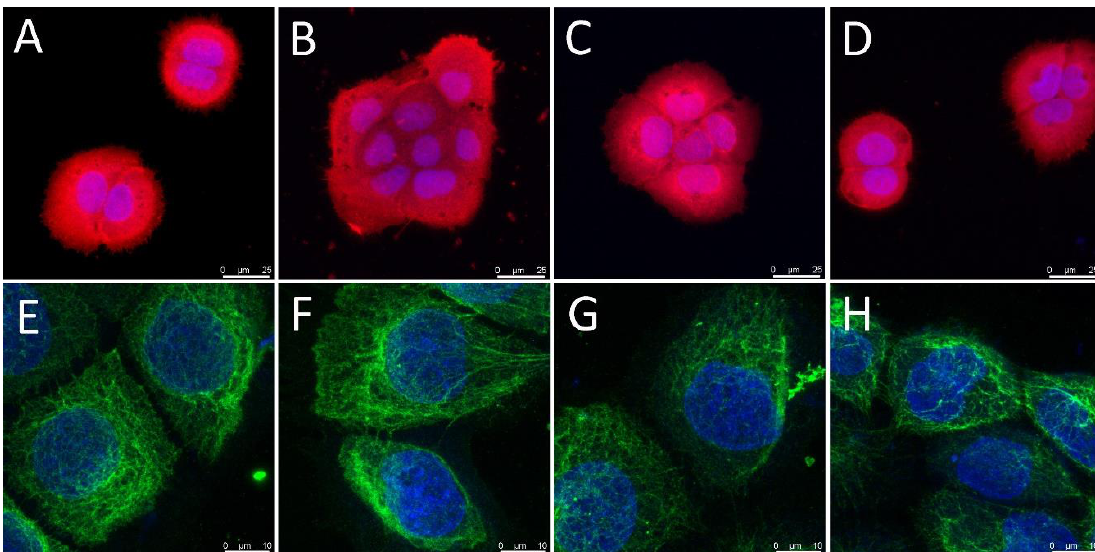
Figure 5. Texas Red C 2 -maleimide staining of the HaCaT cells on day 1 following seeding ( A – D ), and the immunofluores- cence staining of the basal cytokeratins in these cells on day 3 following seeding ( E – H ). The cells were seeded on glass in DMEM containing 2% of FS without the presence of PL ( A , E ), with the presence of 2.5% of PL ( B , F ), with the presence of PVA nanomats ( C , G ) and with the presence of PVA–PL nanomats ( D , H ). The cell nuclei were counterstained with a Hoechst 33258. Leica SPE confocal microscope, scale bar = 25 and obj. × 63 ( A – D ), scale bar = 10 µm and obj.× 100 ( E – H ).